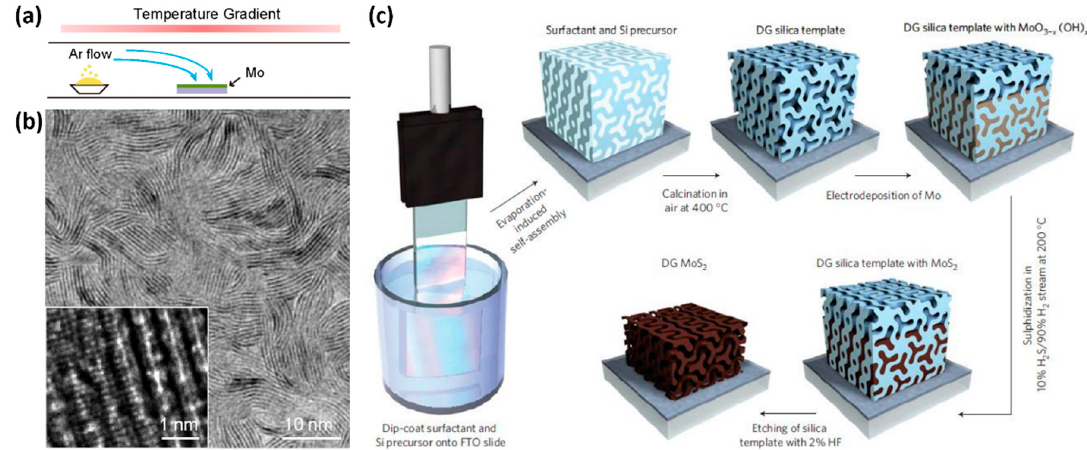
Figure 4. ( a ) Schematic illustration of the synthesis process of vertically aligned MoS 2 film [50]; ( b ) TEM image of vertically aligned MoS 2 that clearly shows the exposed edges. The inset figure was the